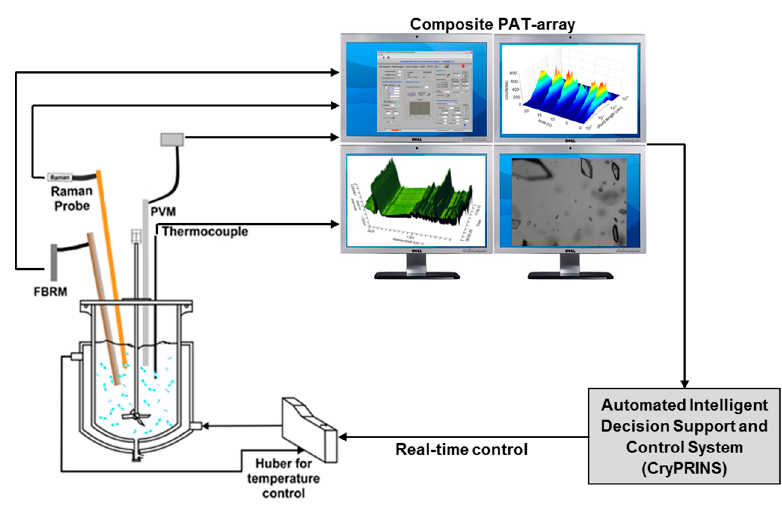
Figure 1. Schematic of the rig used for the experiments.